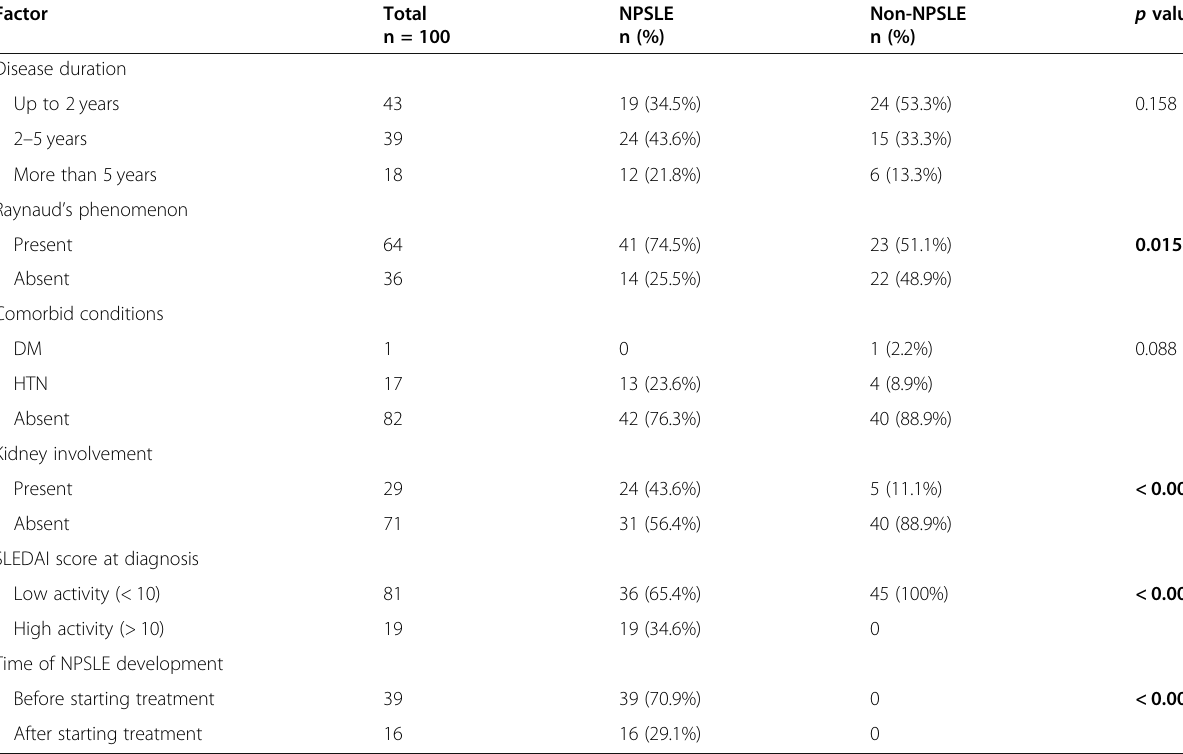
Table 4 Disease-related factors of SLE patients and their association with NPSLE